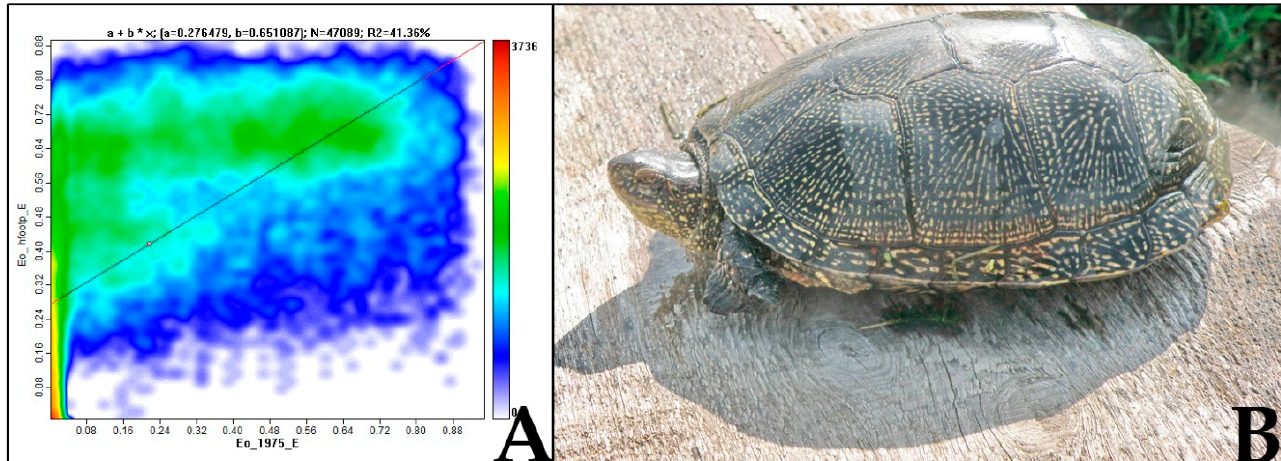
Figure 3. Results of turtles’ living in anthropogenically impacted (artificial including) water bodies: ( A ) dependence graphs of HS from HF (grid SDM, correlation r = 0.6, Saga); ( B ) anomalies of forelimbs of turtles from an artificial pond, Kinburn spit (Ukraine, 2015).